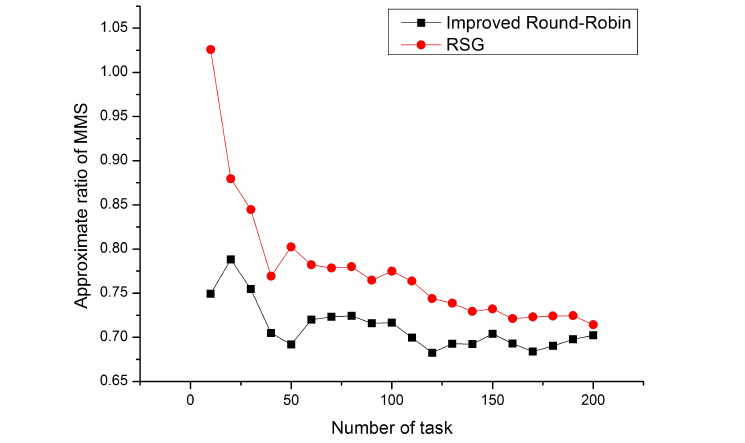
Figure 1. Improved Round-Robin vs.